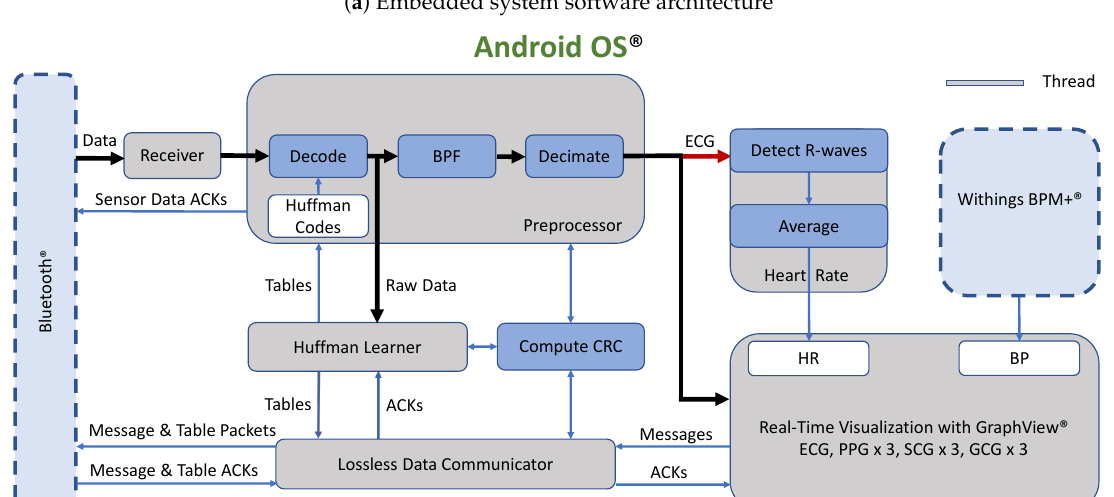
Figure 6. Software architecture for real-time data acquisition of physiological data and lossless data communication over